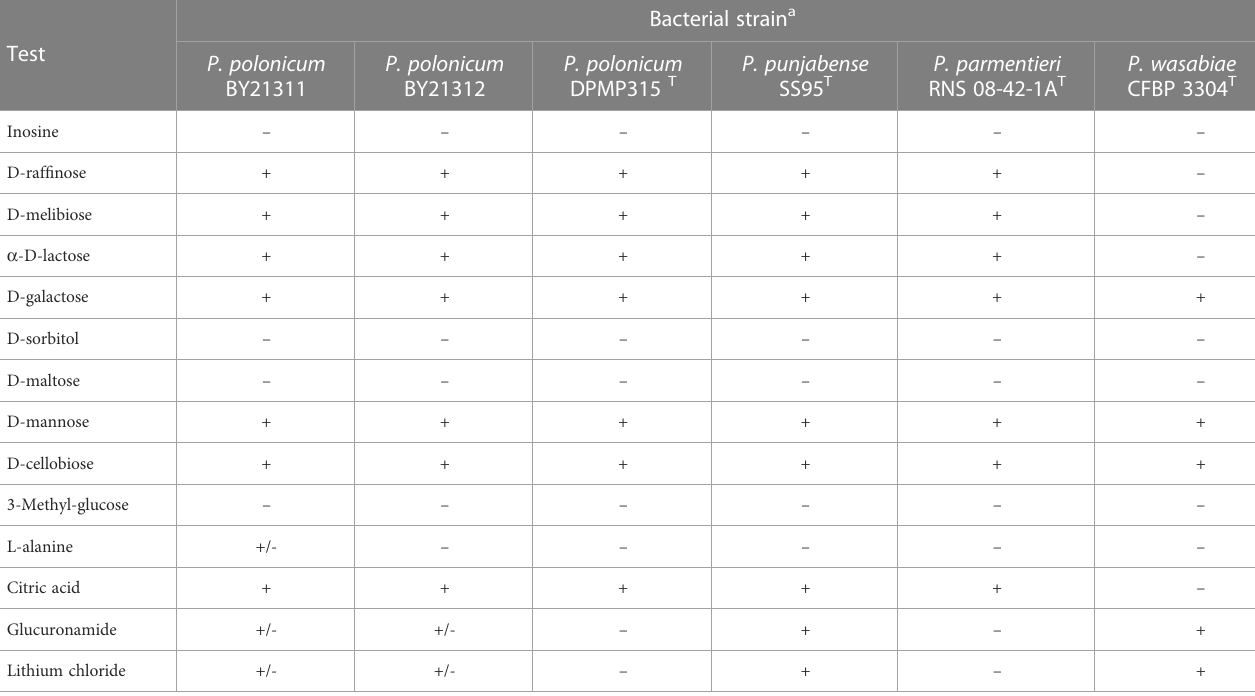
TABLE 2 Physiological and biochemical characteristics of Pectobacterium